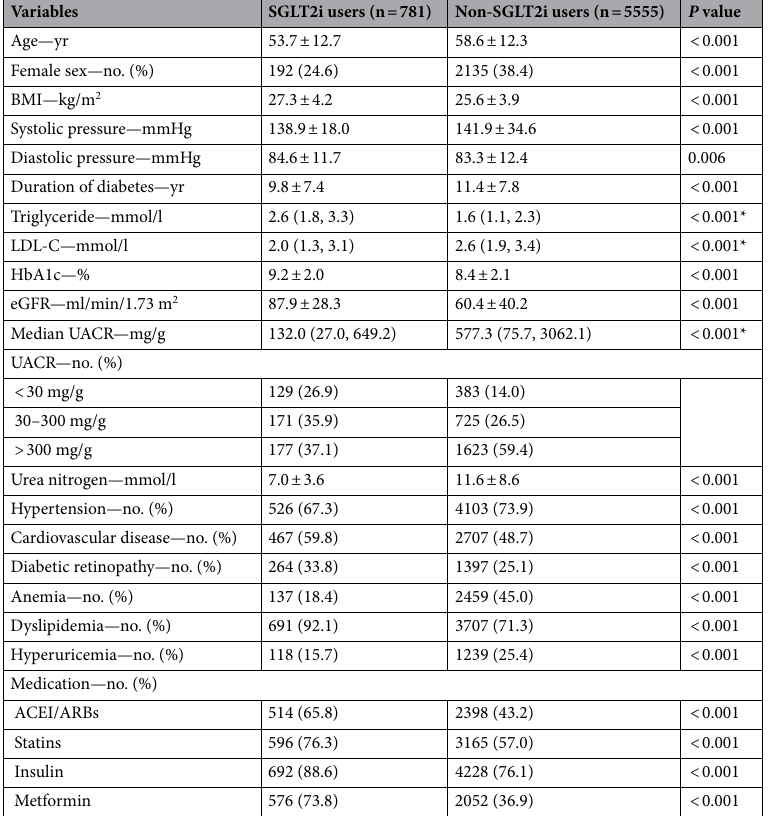
Table 1. Demographic and clinical characteristics for all patients. Data were shown as mean ± standard deviation, median (interquartile) or frequency (percentage). The t-test and chi-squared test were used unless stated otherwise (*Mann–Whitney U-test). SGLT2i, sodium–glucose cotransporter 2 inhibitor; BMI, body mass index; LDL-C, low density lipoprotein cholesterol; HbA1c, glycosylated hemoglobin; eGFR,